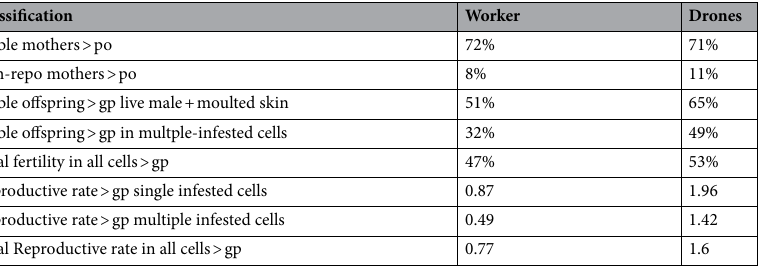
Table 1. Various Varroa reproductive classifications in Cuban worker and drone capped brood cells. The minimum pupal age category is also given. Pale eyes (po) ≈ 100 h in workers and 120 h in drone. Grey pads (gp) ≈ 240 h in workers and 300 h in drones. The moulted skin of male mites is used to confirm they are adults.